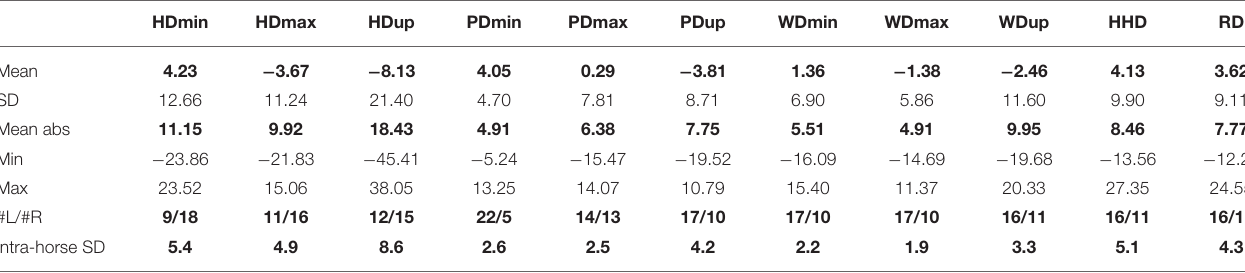
TABLE 1 | Values for 11 upper body movement asymmetry parameters recorded during in-hand